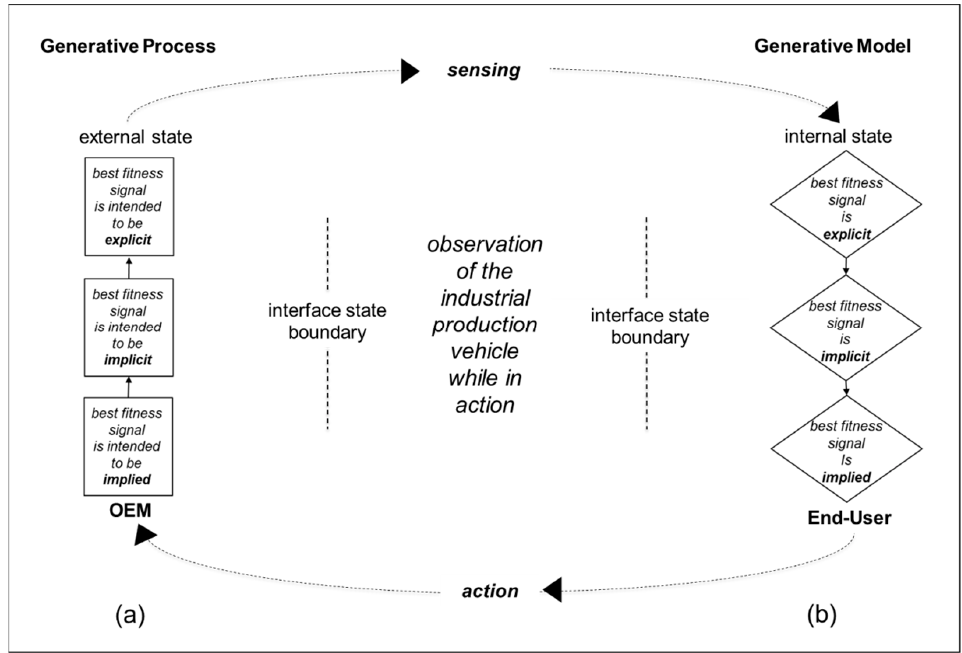
Figure 1. Inter-organizational signaling. ( a ) The developer/vendor (OEM) of a production vehicle intends that its signal of best ecological fitness will be implied, implicit, and explicit. ( b ) User organization observes that the production vehicle does provide explicit, implicit, and implied best fitness.